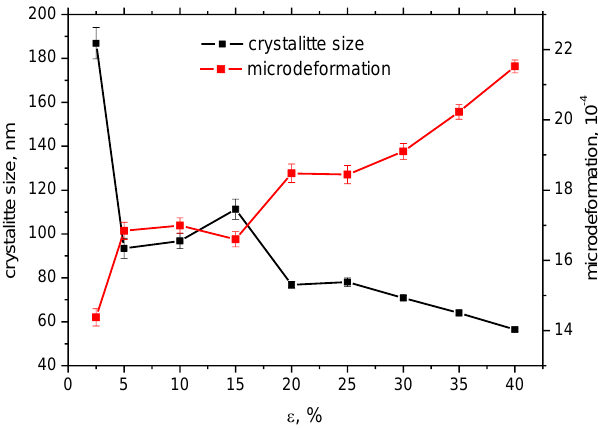
Figure 1. Crystallite size and micro-deformation as a function of ε .